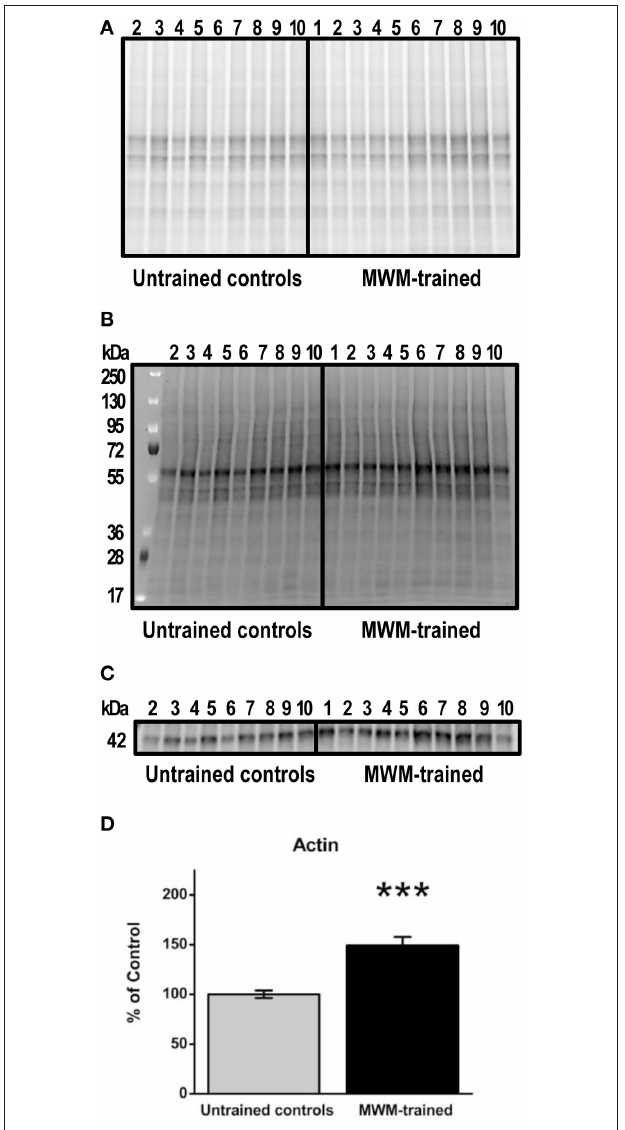
FIGURE 4 | Semi-quantification of actin protein levels in the hippocampus of MWM-trained vs. untrained control CD1 mice. (A) Gel activation image of protein from hippocampal homogenates (15 µ g) using UV illumination-based stain-free technology. (B) Image of nitrocellulose blot after protein transfer, indicating the total amount of protein in each lane that was used for normalization. (C) Representative Western blot detecting total actin (1:500) in hippocampal homogenates from MWM-trained and untrained control mice ( n = 9 –10). (D) Bar graph of densitometry values for actin, normalized to total protein and expressed as percentage change from control mean (100%) ± SEM, from hippocampal homogenates from untrained controls and MWM-trained mice. Error bars represent standard error; *** p < 0.001 .